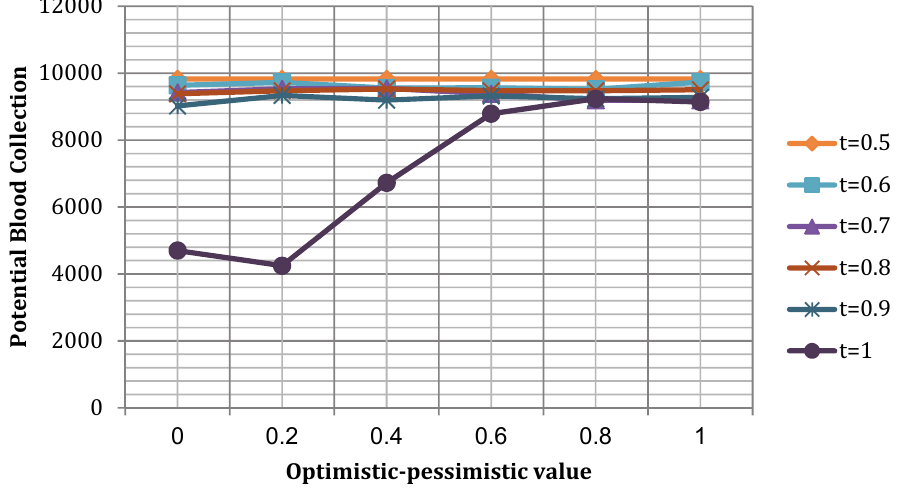
Fig. 3. Potential blood collection based on the different optimistic-pessimistic values and confidence levels for UAM corresponding equivalent single objective ILP